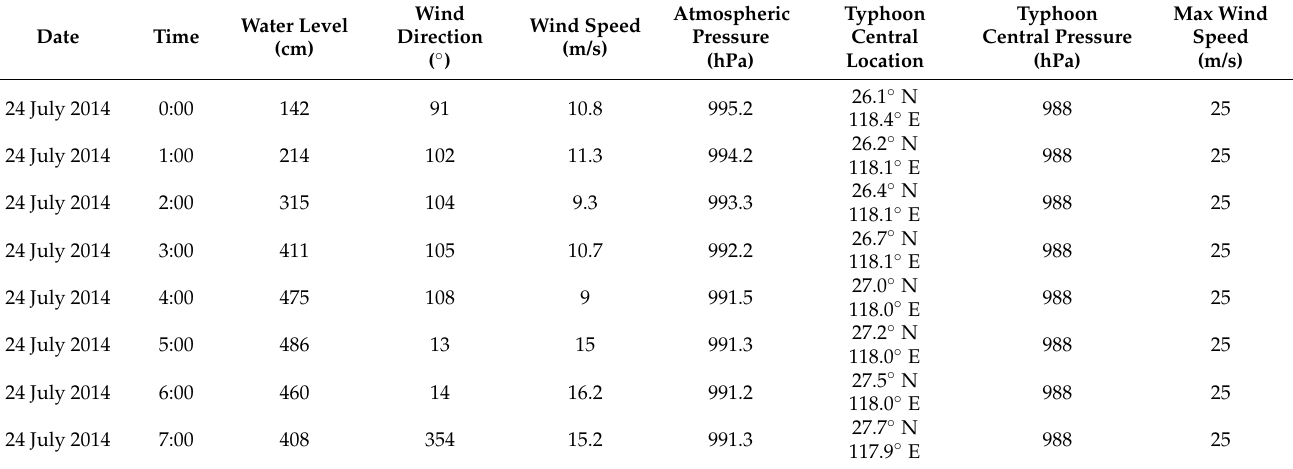
Table 1. Oceanic and meteorological sample data during Typhoon No.